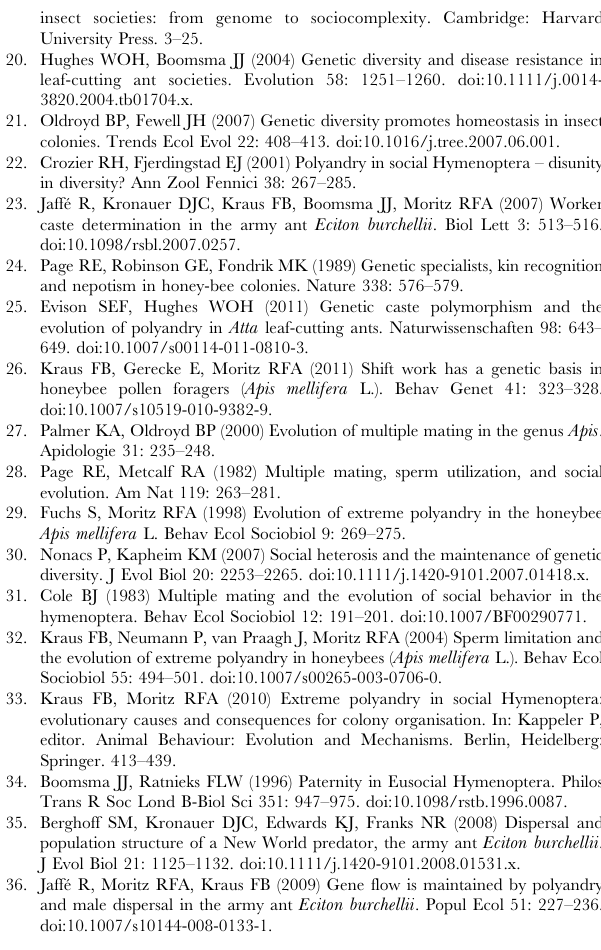
Figure S2 Association of the effective-number-index of paternity skew ( S -index) and average approximate colony sizes across nine army ant species. The solid line indicates the slope of a phylogenetically corrected GLS regression ( b = –0.015, R 2 = 0.03, p = 0.61) and dashed lines the 95% confidence interval. Figure S3 Paternity distribution among 3–6 colonies of the three Neotropical army ant species E. burchellii ( Eb ), E. mexicanum ( Em ) and L. praedator ( Lp ). Alternately shaded bars show the proportional paternity of all patrilines. k obs , number of assigned workers ( n ), paternity skew ( B - index with asterisks marking Bonferroni adjusted significance) and relative inertia of the correspondence analysis are shown above the bars for each colony. Relative inertia give the proportional contribution of each colony to deviation from homogeneity of the paternity distribution within a species. The x 2 -statistics of the correspondence analysis, given per species above the diagram, indicates no significant deviation among colonies for neither species. Table S1 Characteristics of five new microsatellite loci developed for the Neotropical army ant Labidus prae- dator .